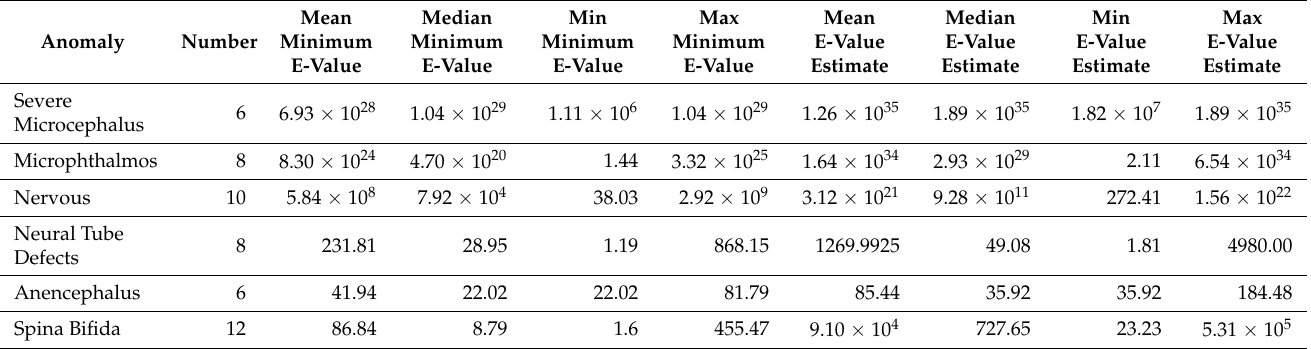
Table 8. Summary of E-Values by